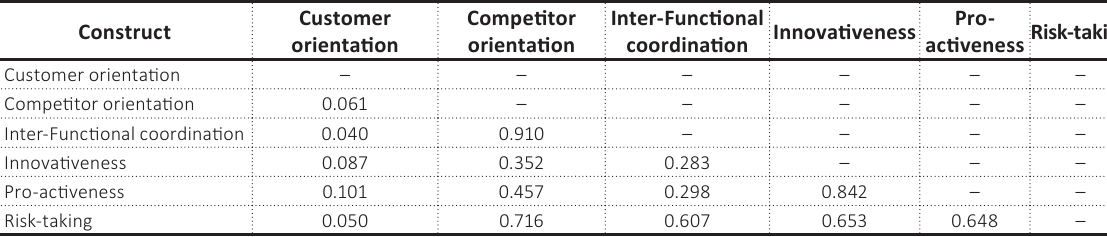
Table 6. R-Square